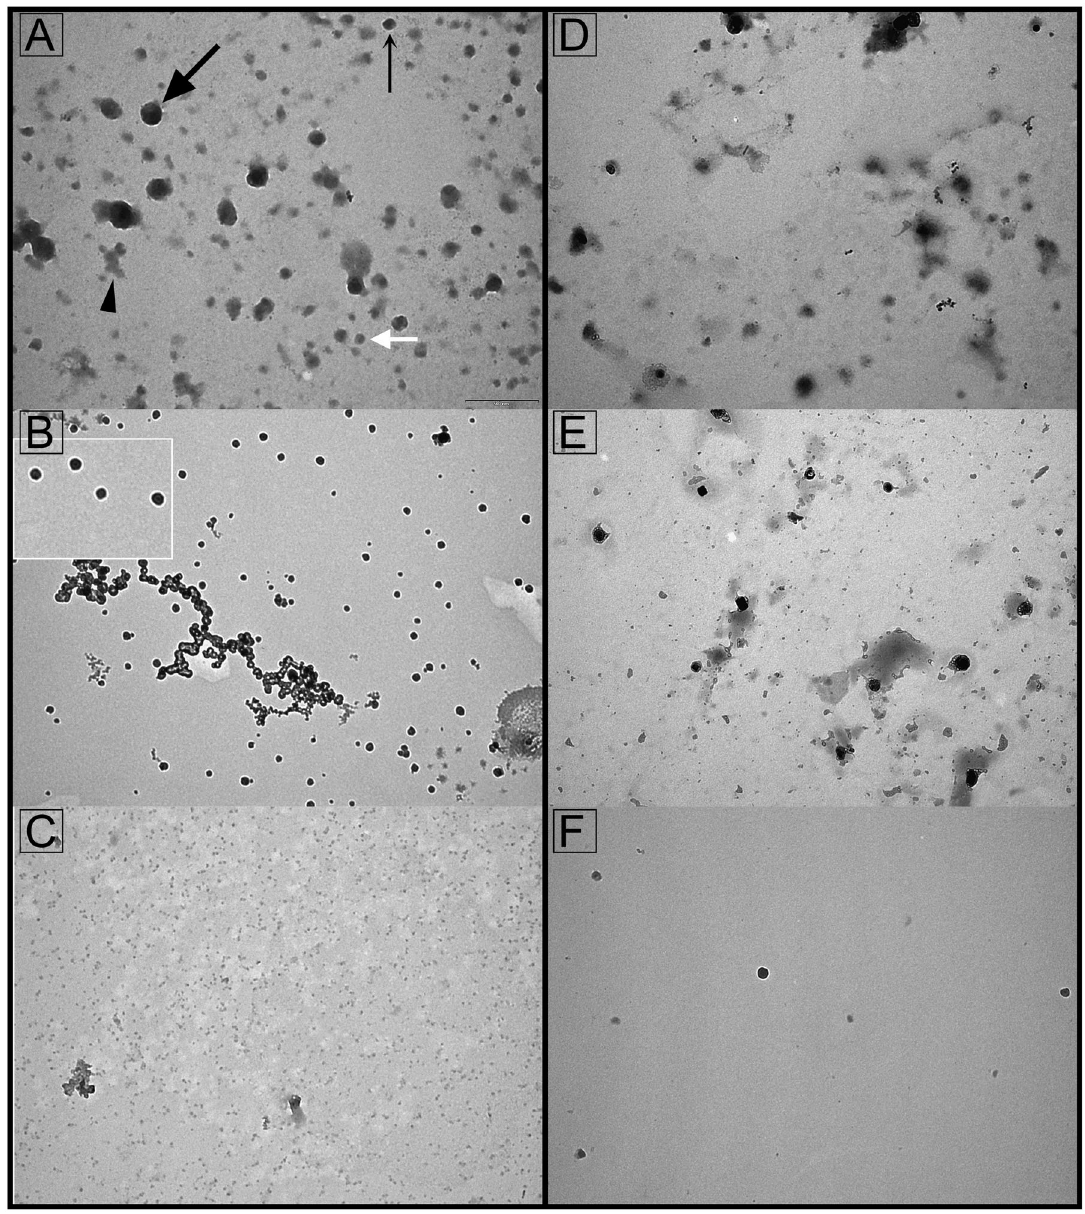
Figure 1. Transmission electron microscopy of seminal prostasomes from normozoospermic men separated by lectin-affinity chromatography. Micrographs of vesicles (70 – 170nm) in a concanavalin A (Con A)-non-bound fraction (A). A dense vesicle (thin arrow), a dark vesicle (thick arrow), a light vesicle (white arrow), and amorphous material (arrowhead) can be clearly observed. Single (50 – 90nm) or aggregated vesicles were present in a Con A-bound fraction (B). The insert shows the typical cup-shape appearance enlarged. Micrographs of vesicles (50 – 100nm) in wheat germ agglutinin (WGA)-non-bound fraction (D) and vesicles (50 – 100nm) in a WGA-bound fraction (E). Vesicles in the high-pH-eluted fraction from Con A column (C) and low-pH-eluted fraction from WGA column (F) were